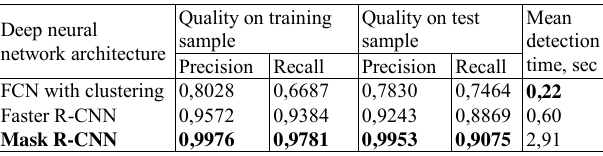
Table 1. Comparison of deep neural